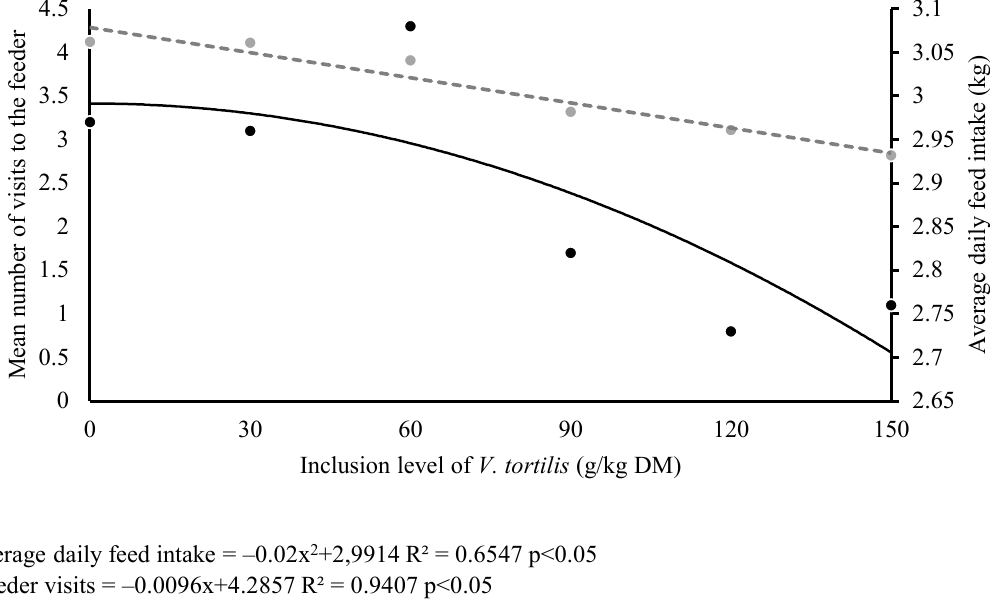
Feeder visits = – 0.0096x+4.2857 R² = 0.9407 p<0.05